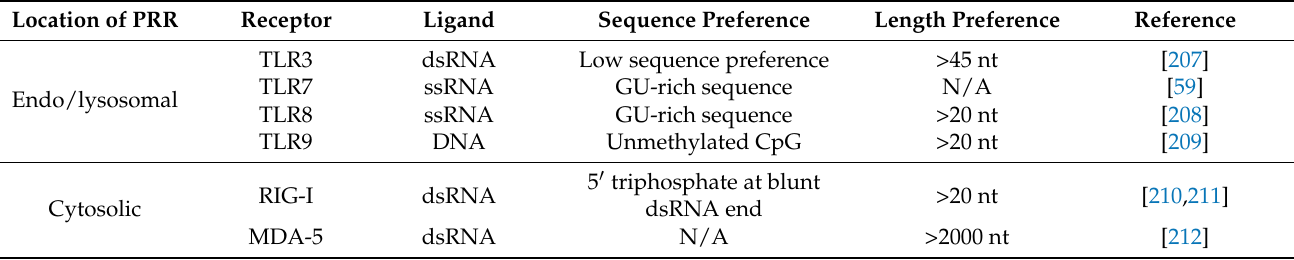
Table 2. Innate immune receptors sensing of